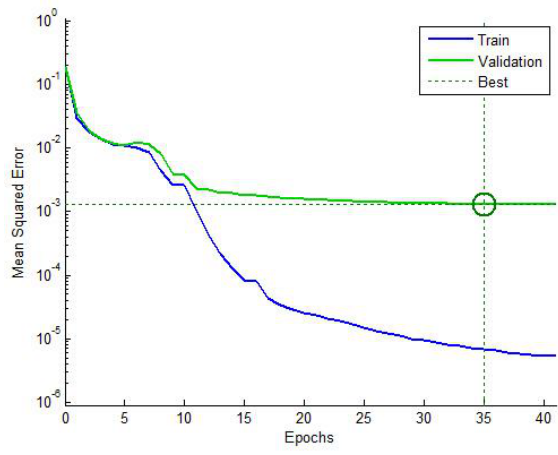
Fig. 1. Performance of the training and validation data sets in terms of MSE